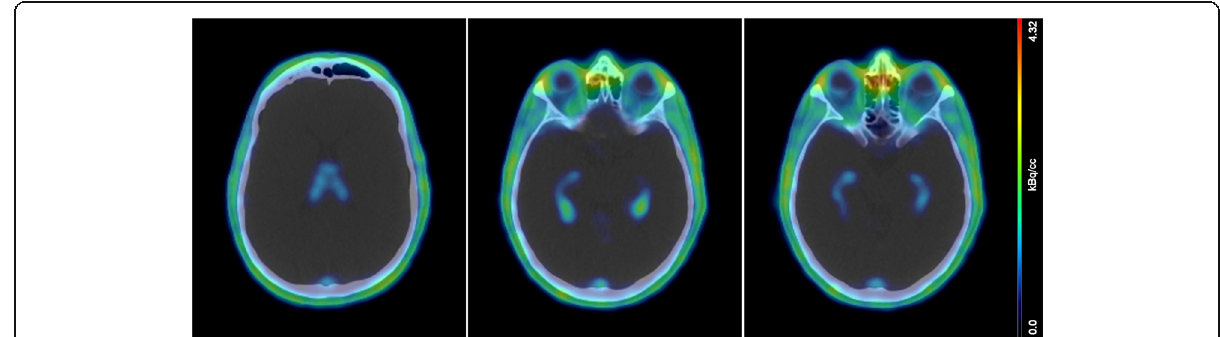
Fig. 2 Typical uptake pattern in the choroid plexuses of the lateral ventricles. Left-hand site panel shows 68 Ga-NODAGA-RGDyK absence of uptake